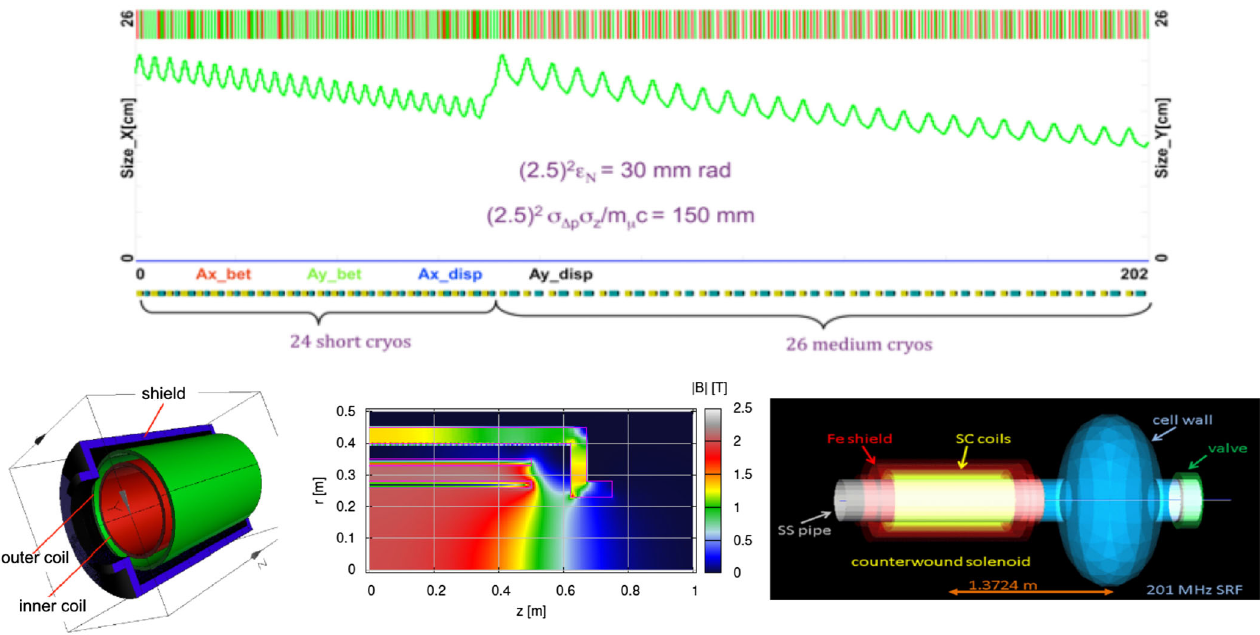
FIG. 9. Top panel: Layout of the muon linac consisting of 24 one cavity modules and 26 two cavity modules to achieve a final energy of 0.9 GeV. The lower left-hand panel shows an electromagnetic model of the superconducting solenoid, the lower center panel shows the field distribution at the end of the solenoid and the lower right-hand panel shows one short cryo-module.